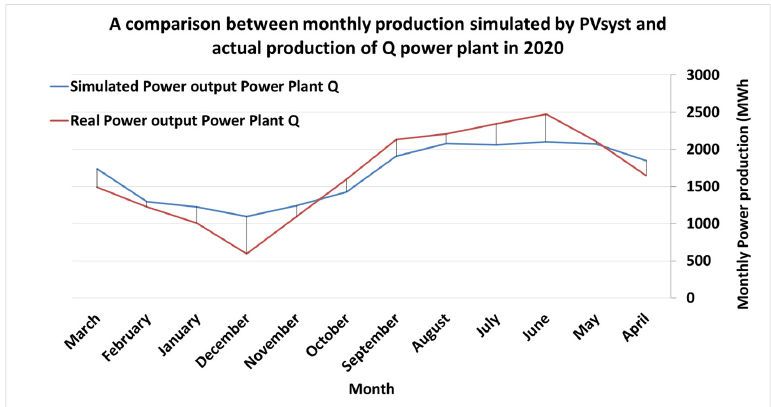
Figure 13. Approximate comparison between monthly production simulated by PVsyst and actual production of Q power plant in 2020.